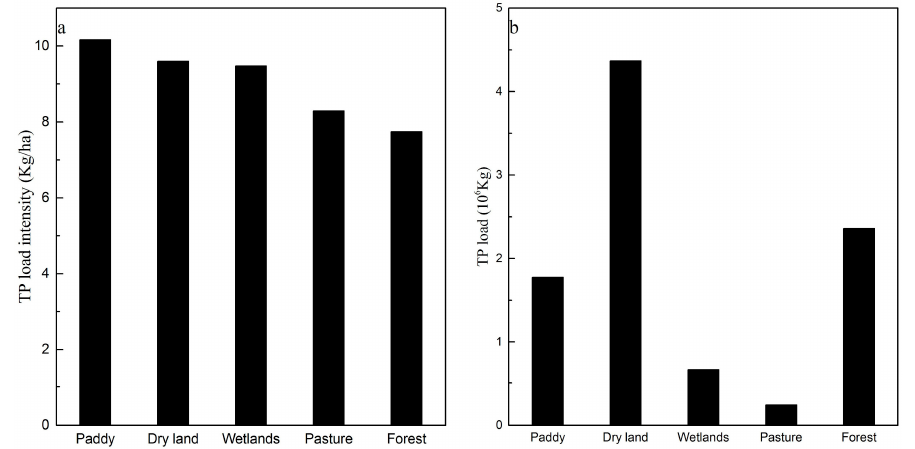
Figure 7. Load intensity ( a ); and load ( b ) of total phosphorus (TP) from each land use between 2001 and 2010.